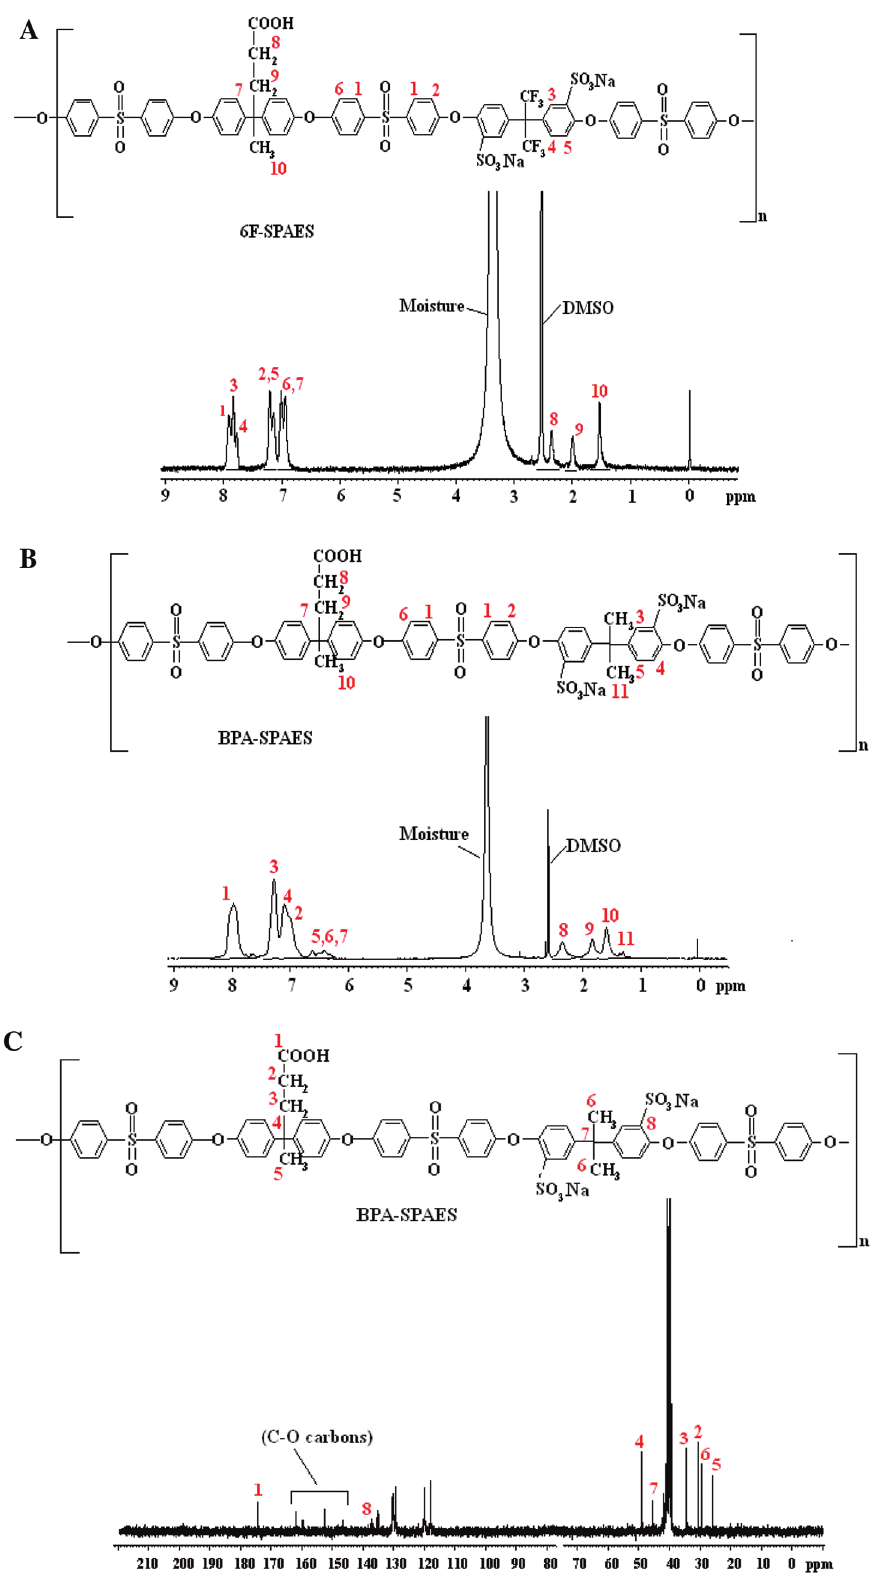
Figure 4: (A) and (B) 1 H NMR spectra of 6F-SPAES and BPA-SPAES copolymers, (C) 13 C NMR spectrum of BPA-SPAES copolymer,